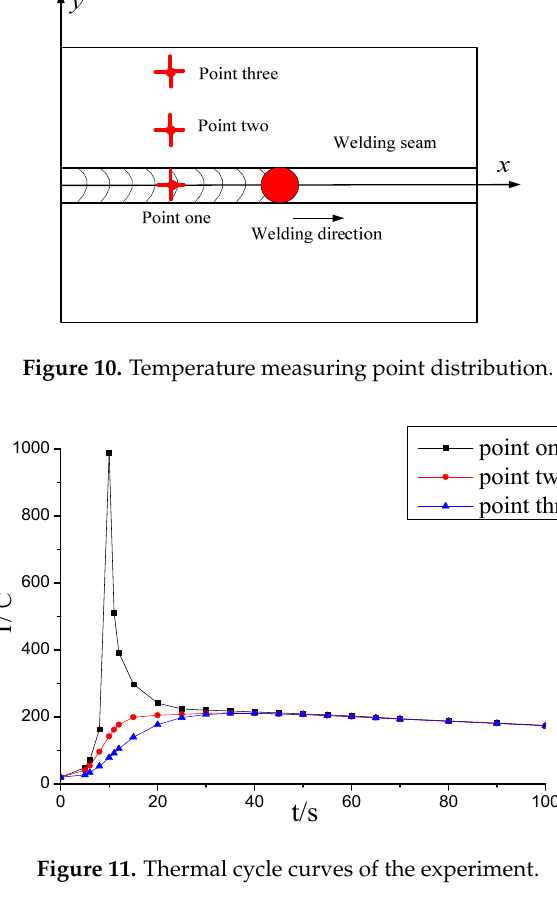
Figure 11. Thermal cycle curves of the experiment.